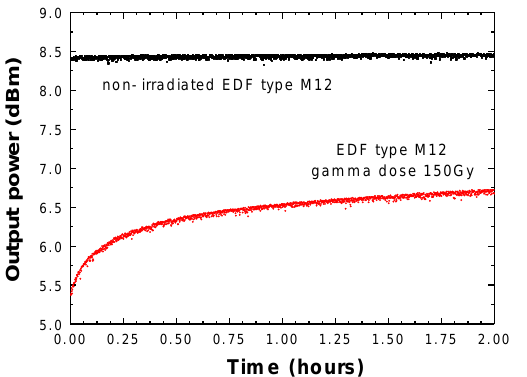
Figure 3. Output power variation over time when using 5 m of a non-irradiated EDF M12 (black) or an IEDF M12 with 150 Gy (red).